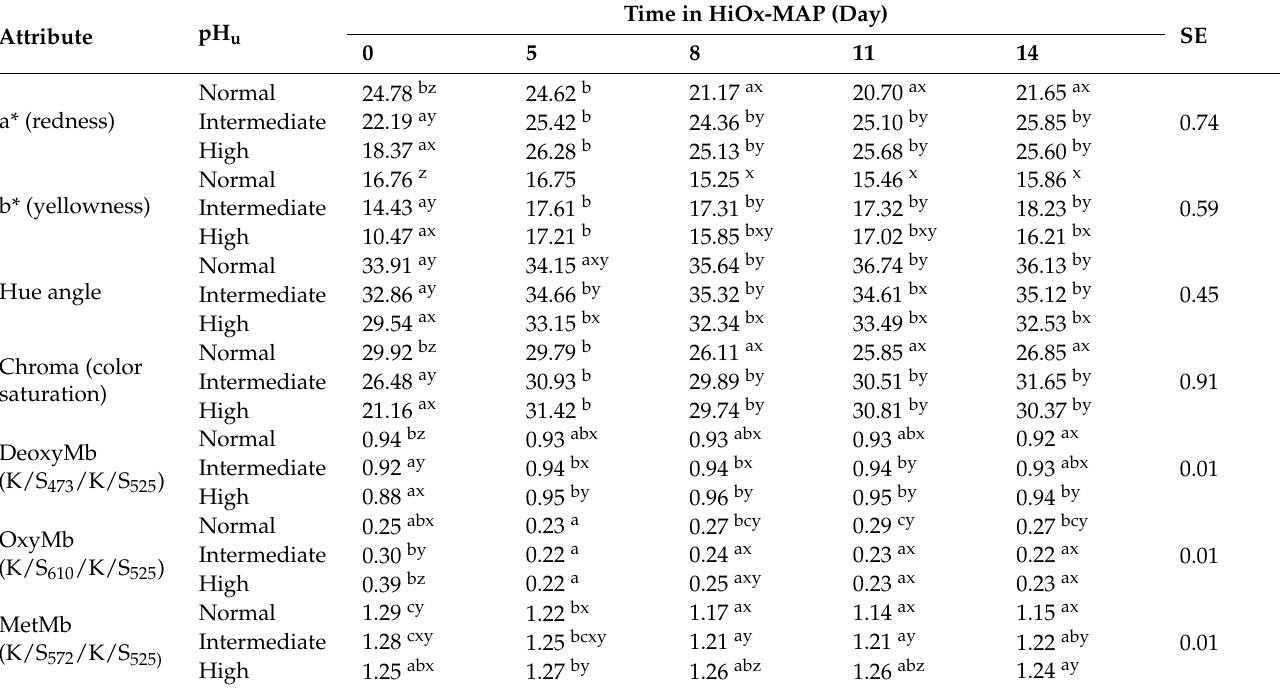
Table 4. Time-related changes at instrumental color parameters and surface myoglobin forms